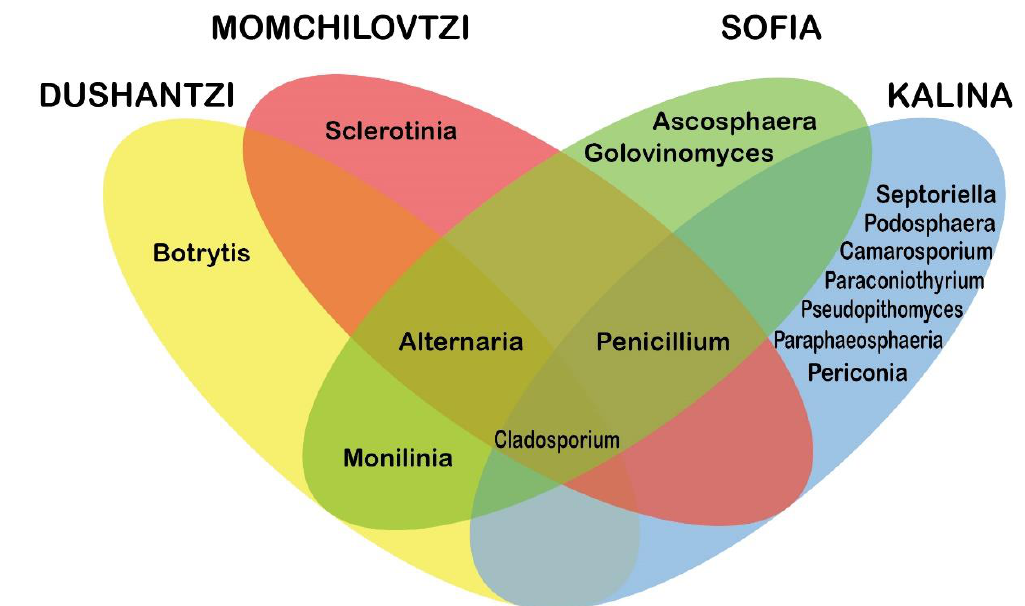
Figure 6. Venn diagram of the dominant fungal genera in the four locations.